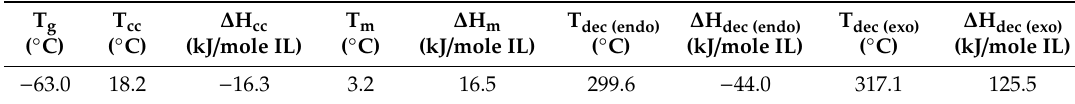
Figure 6. Di ff erential Scanning Calorimetry ( DSC) curve for DmiBr (exoˆ). Figure 6. Differential Scanning Calorimetry ( DSC) curve for DmiBr (exo^). Table 5. Di ff erential Scanning Calorimetry ( DSC) analysis of DmiBr (T g —glass transition, T cc —cold